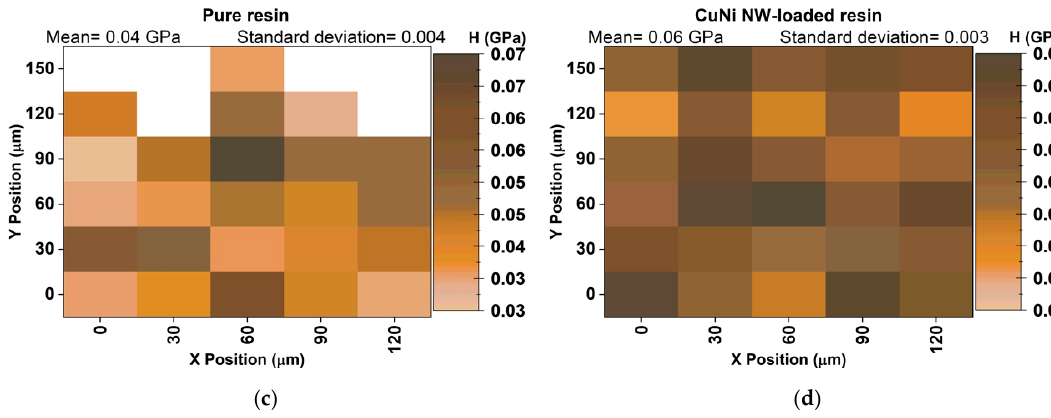
Figure 4. Mappings of the mechanical properties E ( a , b ) and H ( c , d ), obtained from the nanoindentation tests on the surface of the pure and CuNi NW-loaded resin substrates, respectively. A total surface area of 120 × 150 µ m 2 was analyzed on each substrate.